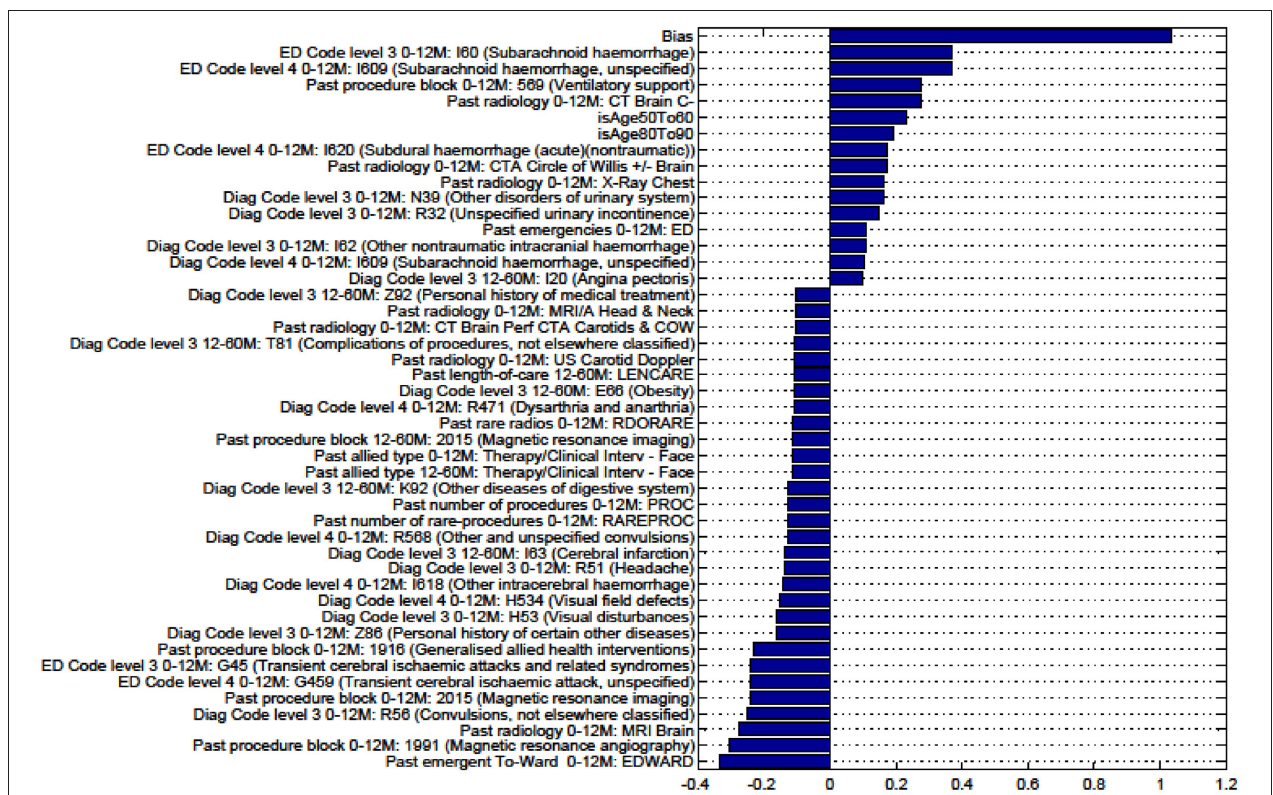
FIGURE A2 | Factors for prediction of Discharge to Rehabilitation vs Home for the sub-cohort of intracerebral hemorrhage stroke patients.